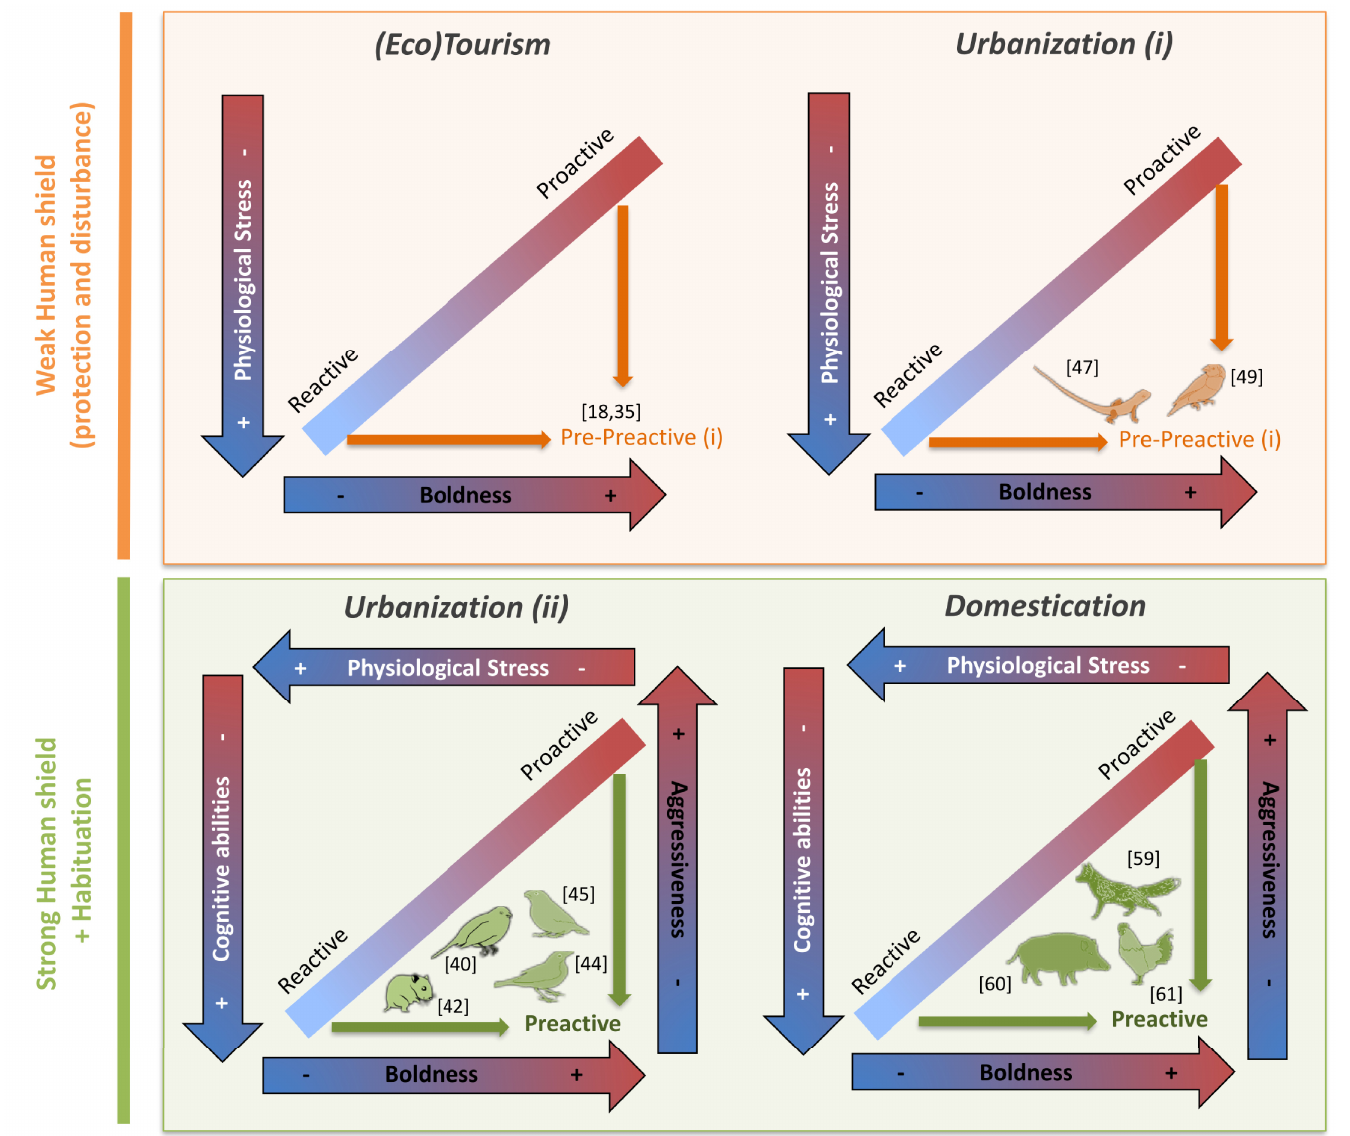
Fig 1. Uncoupling of physiological (in white) and behavioral (in black) coping style traits in, (Eco)tourism, Urbanization, and Domestication contexts. The orange panel represents the case where intensity of human contact is weak, which results in the uncoupling of physiological and behavioral traits within coping styles (i). The green panel represents the cases where the intensity of human contacts is strong, which results in the uncoupling within either physiological or behavioral traits, and creates preactive individuals. The blue to red arrows on the edges represent x and y axes characterizing behavioral and physiological differences between reactive and proactive coping styles. The smaller arrows (orange or green) highlight the shifts outside the classic reactive–proactive continuum which is related to human presence. Note that we purposely focused on the 2 extreme coping styles to better unpack and illustrate the logic behind our hypothesis. The number refers to the references associated with the finding. Species design : Pierre Lopez (MARBEC)